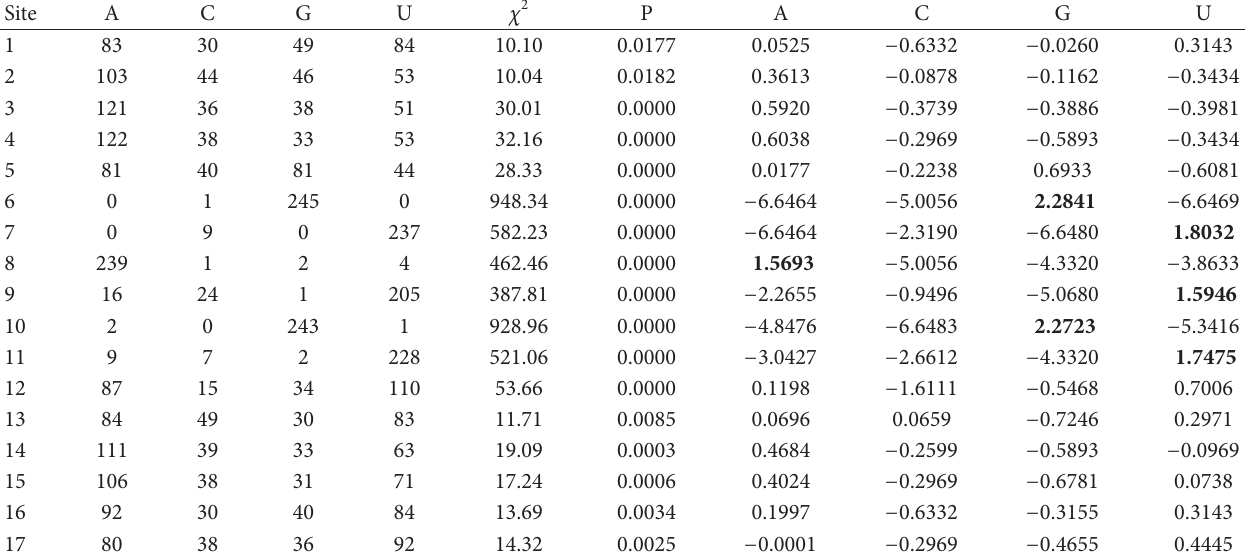
T 1: Site-speci�c frequencies and position weight matrix (PWM) for 246 donor splice sites (each represented by 5 sites on the exon side and 12 sites on the intron side).